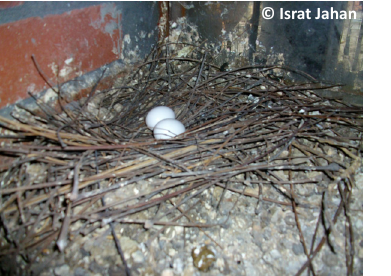
Image 1. Rock Pegion nest